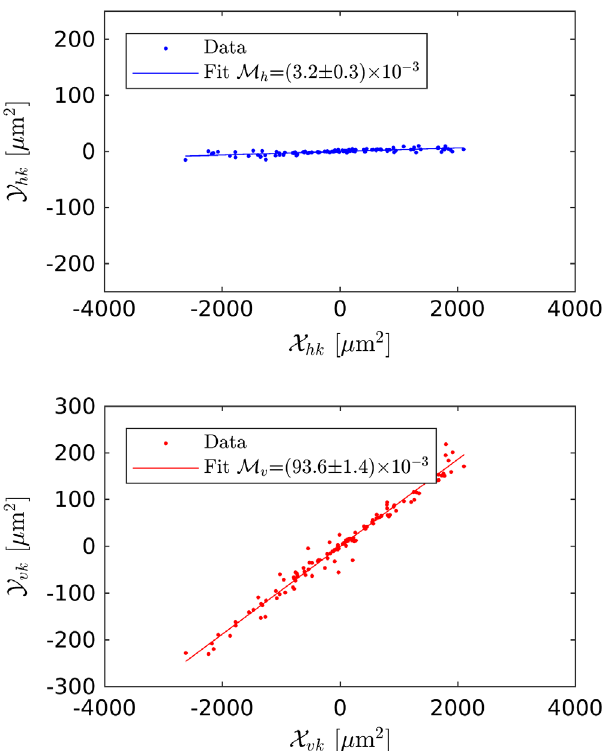
FIG. 6. Example of a M h and M v linear fit using the combined data of the 120 BPMs before and after a dc skew quadrupole changed by 2.5A. Using Eq. (10), the resulting offsets are x 0 l ¼ 265 . 3 (cid:2) 7 . 0 μ m. The data shown here 330 . 7 (cid:2) 0 . 5 μ m and y 0 l ¼ corresponds to the case l ¼ 10